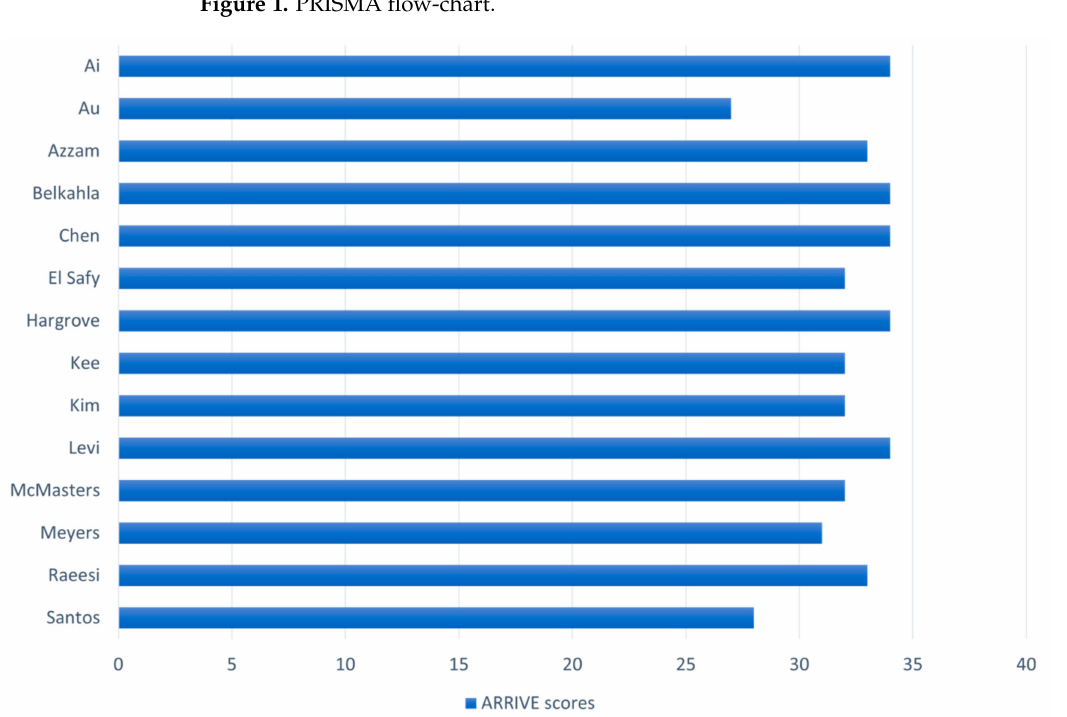
Figure 1. PRISMA flow-chart.